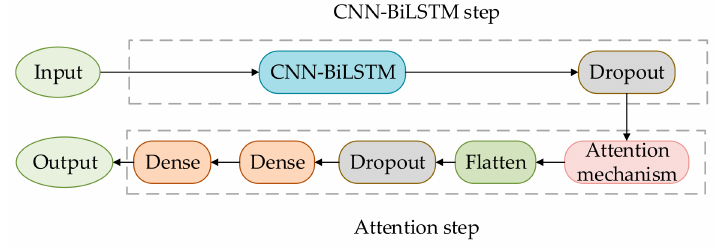
Figure 3. The steps of prediction